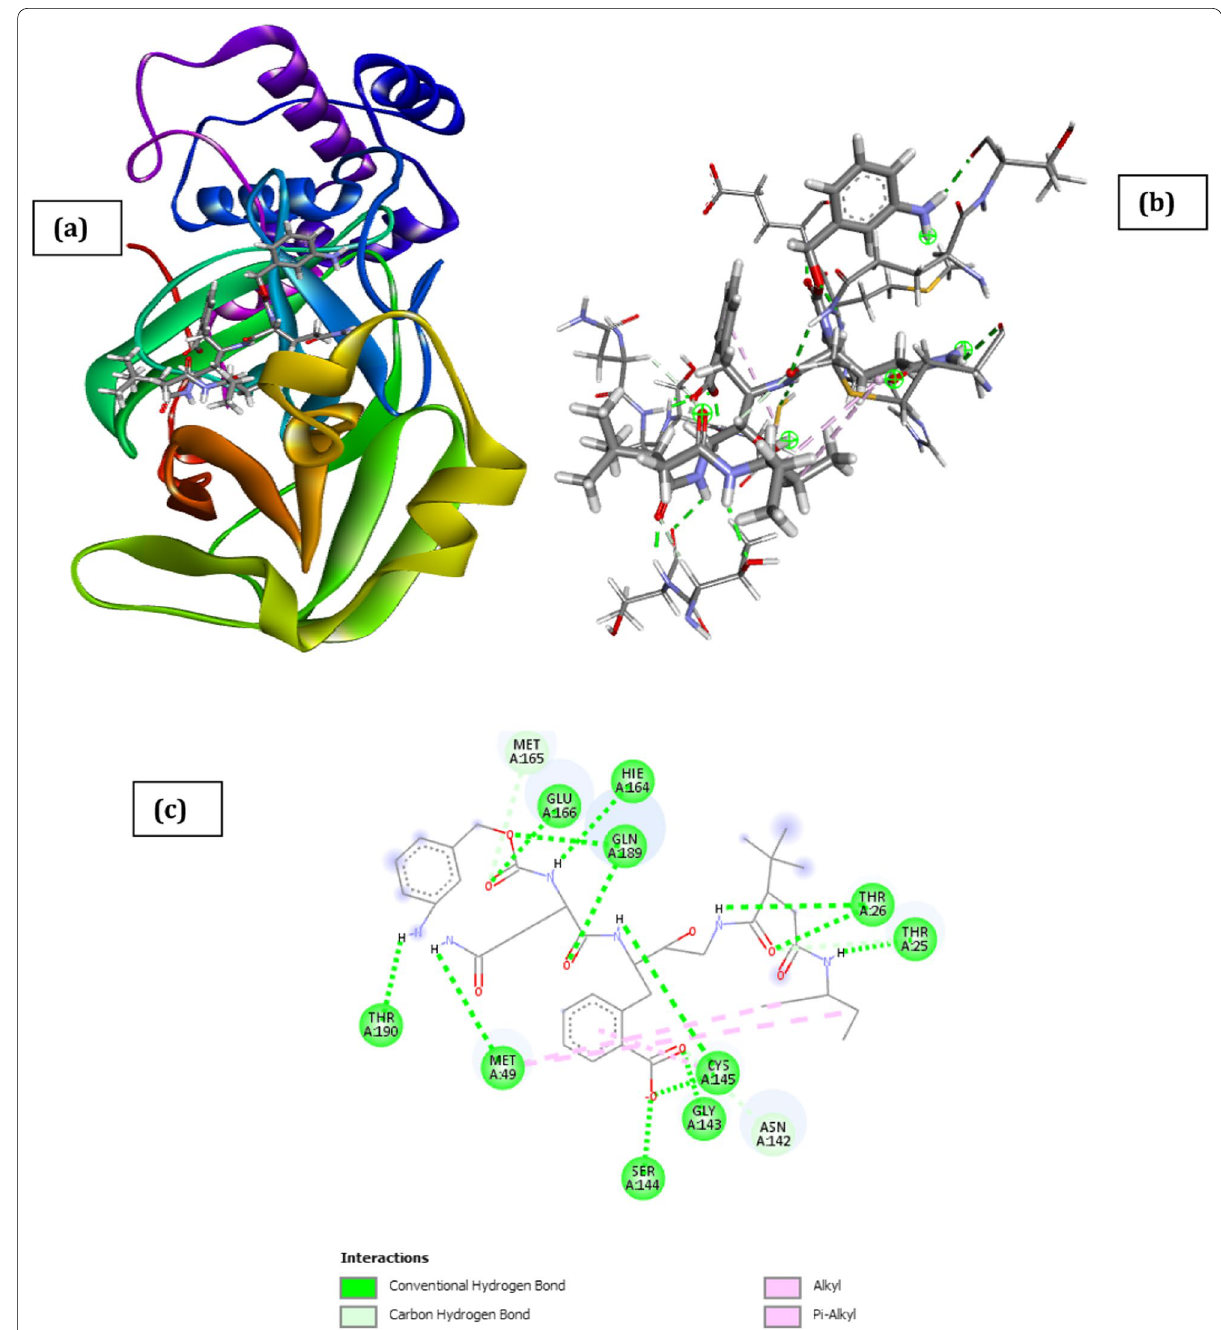
Fig. 10 Docked poses of SARS CoV 2 main protease (PDB ID: 6XBH) with inhibitor with Index number 847b (stick figure) a 3D view of docked pose of SARS CoV 2 Main Protease (PDB ID: 6XBH) with inhibitor with Index number 847b; b 3D view of inhibitor with Index number 847b with surrounding amino acids of 6XBH; c 2D view of interaction type of inhibitor with Index number 847b with surrounding amino acids of